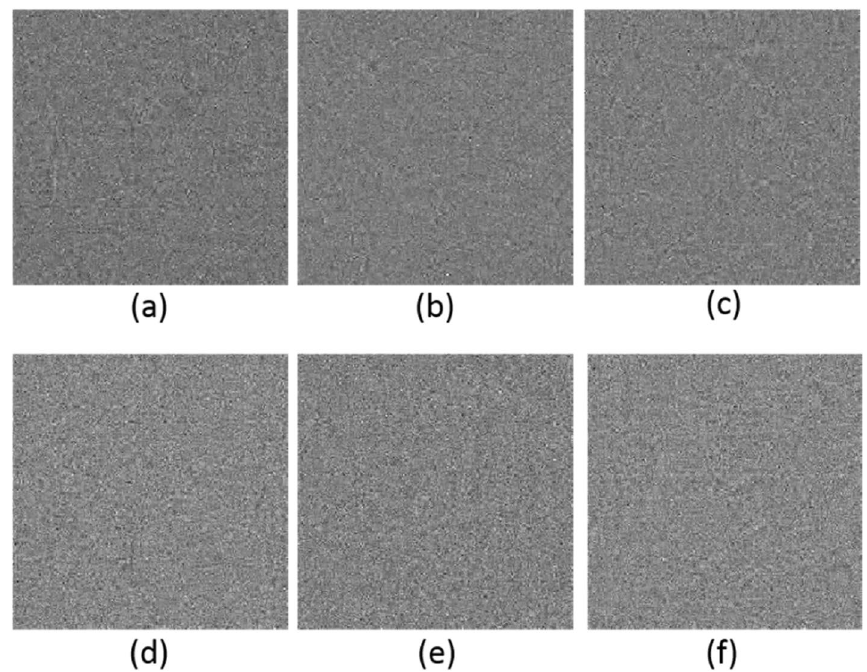
10 − 15 ; + 10 − 15 ; ( d ) decrypted image with + 10 − 15 +